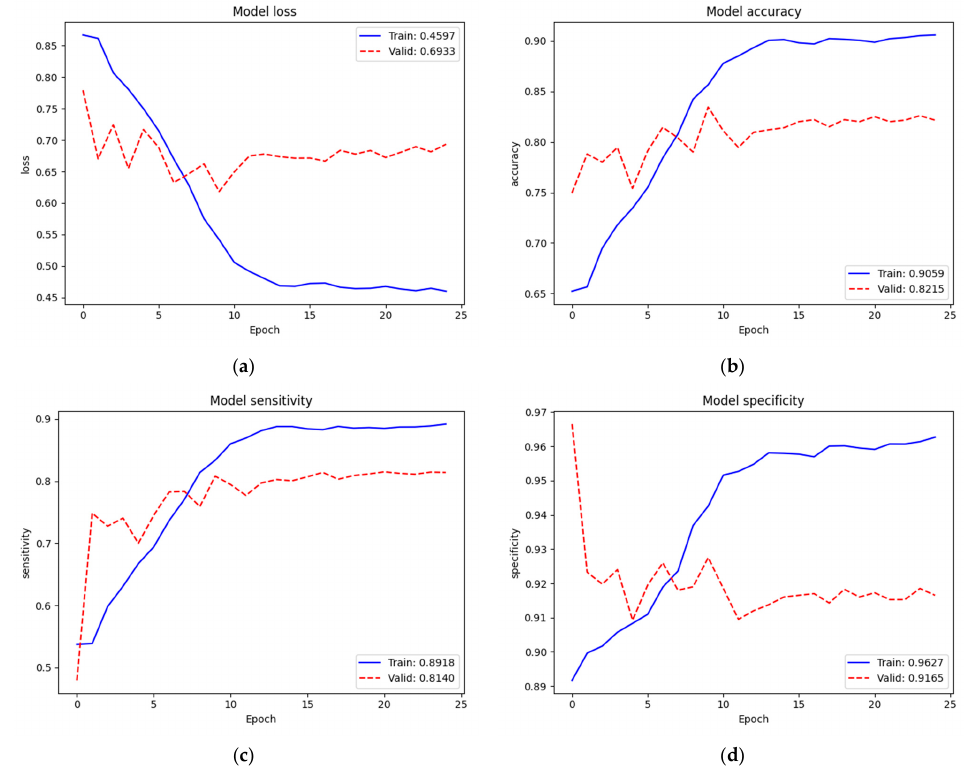
Figure 7. Train and validation performances of the NIH data set on the complete model: ( a ) loss; ( b ) accuracy; ( c ) sensitivity; ( d ) specificity.